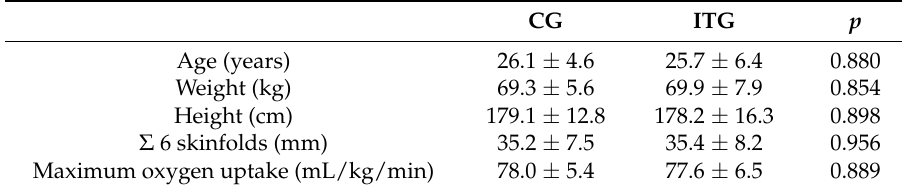
Table 1. Physical and anthropometric characteristics in the control group (CG) and iron treatment group (ITG) at baseline (T1).